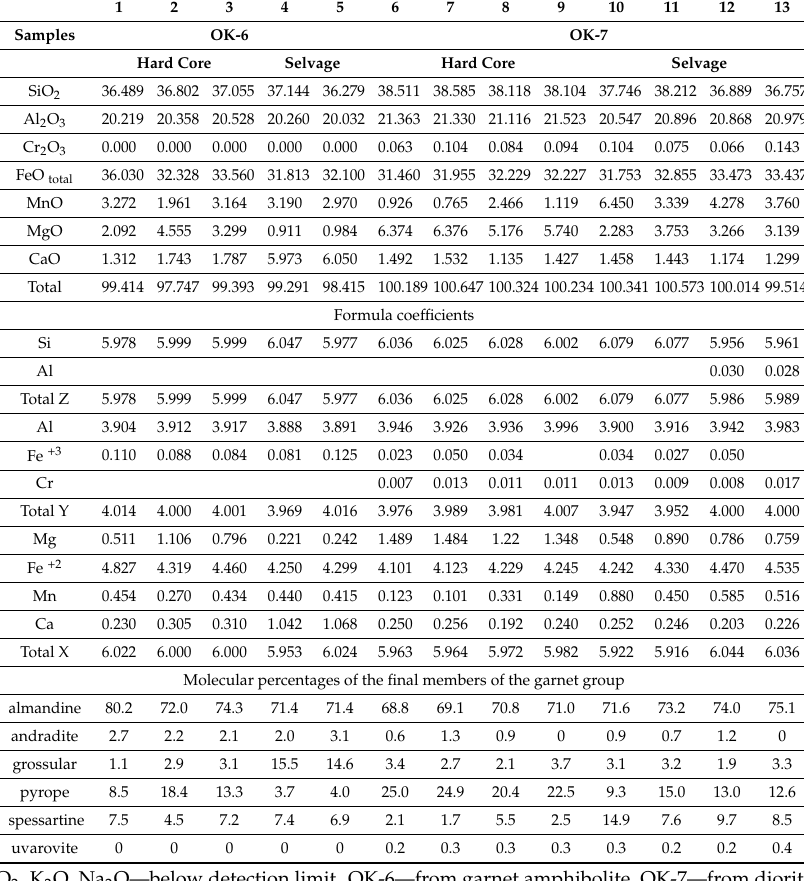
Table 3. Chemical composition of garnets from the rocks of the DW block (wt